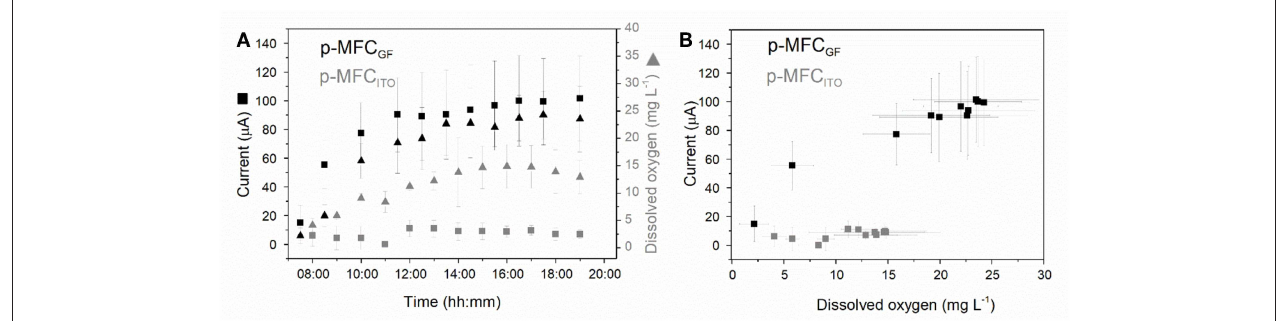
FIGURE 3 | Investigating the relationship between dissolved oxygen in the catholyte and current generated by the p-MFCs under light. (A) Dissolved oxygen (triangles) and current (squares) evolution with time over the 12h of light for p-MFC GF (black) and p-MFC ITO (gray) (B) Correlation between the catholyte DO and the current, derived from (A) . Data is the average of six replicates.